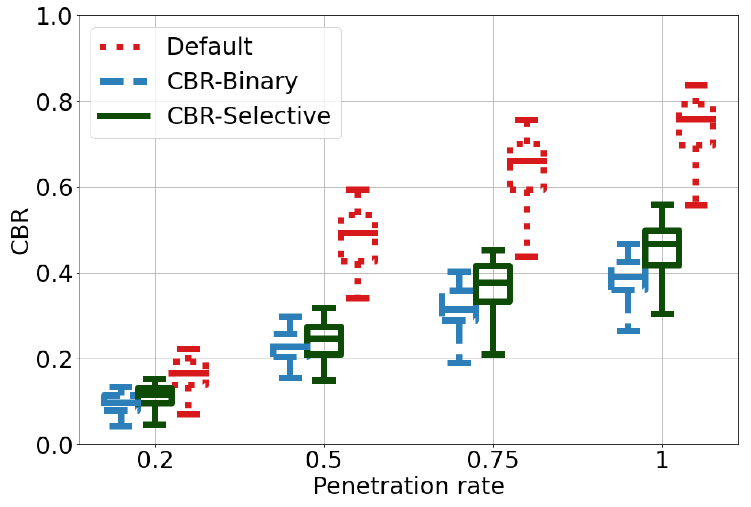
Figure 6. CBR function of penetration rate for CBR-Selective, CBR-Binary and Default